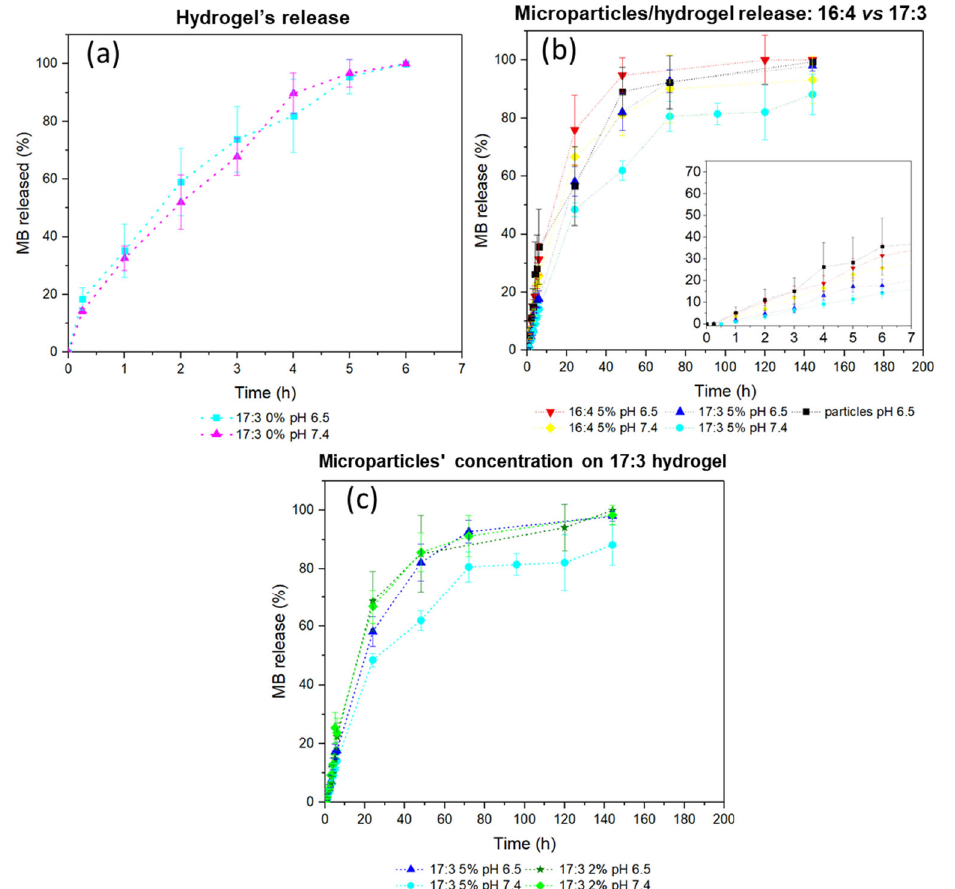
Figure 8. ( a ) Release profile of MB-loaded Pluronic hydrogel, 17:3 F127:F68 ratio, in PBS pH 6.5 and pH 7.4; ( b ) Release profiles of microparticles (in PBS pH 6.5) and microparticle–hydrogel composite system for 16:4 and 17:3 F127:F68 ratios (5 wt.% of microparticles) in PBS pH 6.5 and pH 7.4; ( c ) Release profile of microparticle–hydrogel composite system with F127:F68 ratio 17:3 with 2 wt.% and 5 wt.% microparticles in PBS pH 6.5 and pH